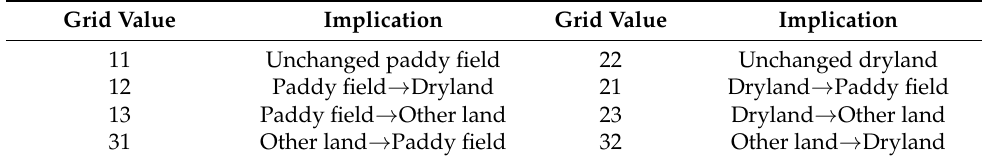
Table 1. The attribute data and the implication of the land-use change.